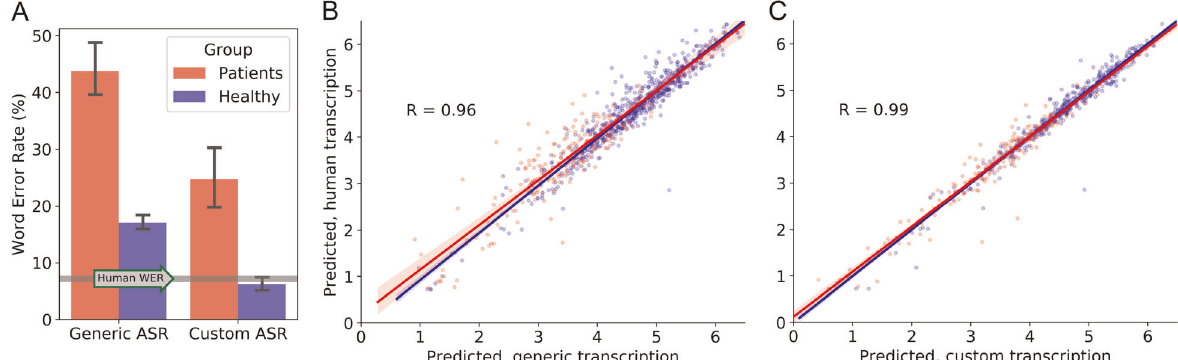
Fig. 2 Accuracy of the automatic speech recognition (ASR) systems was different between the two ASR approaches and the two groups, but this did not have a large effect on predicted ratings. a The ASR had a lower word error rate on responses from healthy participants compared to responses from patients. The word error rate was also lower on an ASR system customized to the verbal memory task, compared to a generic, off-the-shelf system. The custom system approached the level of errors from human transcribers (7.2%), level indicated by the grey horizontal line. Error bars represent the 95% con fi dence intervals of the means. b Scores from a predictive model using natural language processing methods on human transcription was highly correlated with scores derived using transcriptions from a generic system with higher word error rates. c Scores derived from transcriptions using a customized ASR system with lower error rates correlated even better with scores derived using the resource-demanding human transcription procedure, arguably producing equivalent